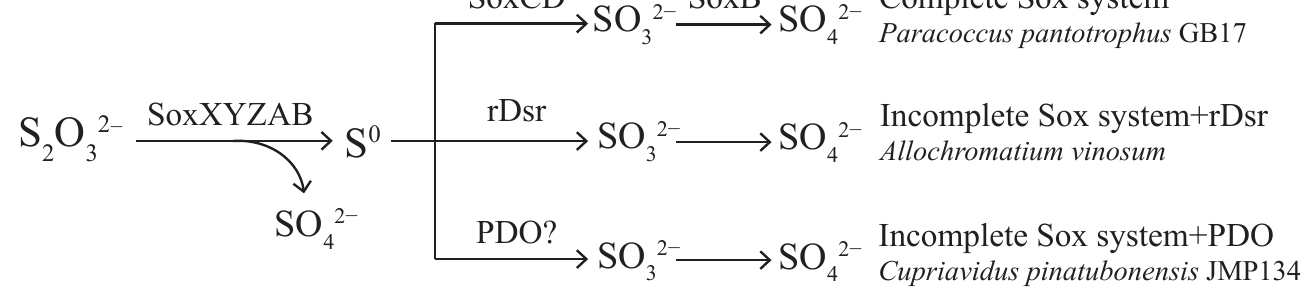
pantotrophus GB17 [13]. Cupriavidus pinatubonensis JMP134 contains a complete Sox